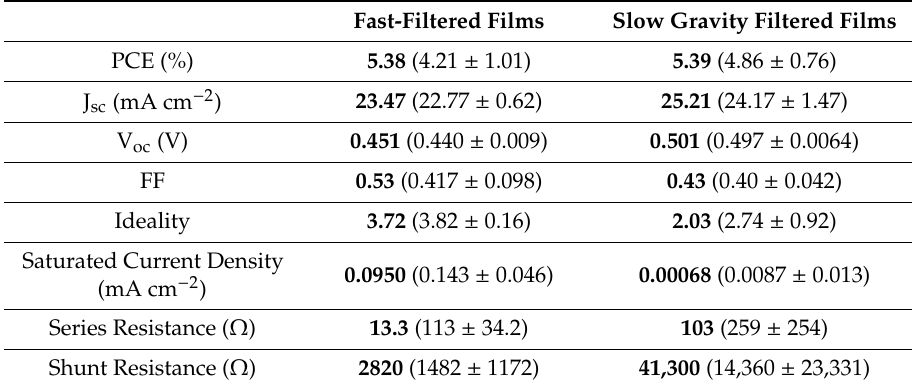
Figure 7. J / V properties for devices with slow and fast-filtered SWCNT films from 500 µ L aliquots. Figure 7. J/V properties for devices with slow and fast-filtered SWCNT films from 500 µL aliquots. Table 4. Device data for fast and slow-filtered films formed from 500 µ L aliquots of CNT suspension. As per the films used previously, the slow-filtered film segments used for solar device Best performing values are bolded, with the average and error in and so two films were used in each case. The fast-filtered films were found to be between 85% and